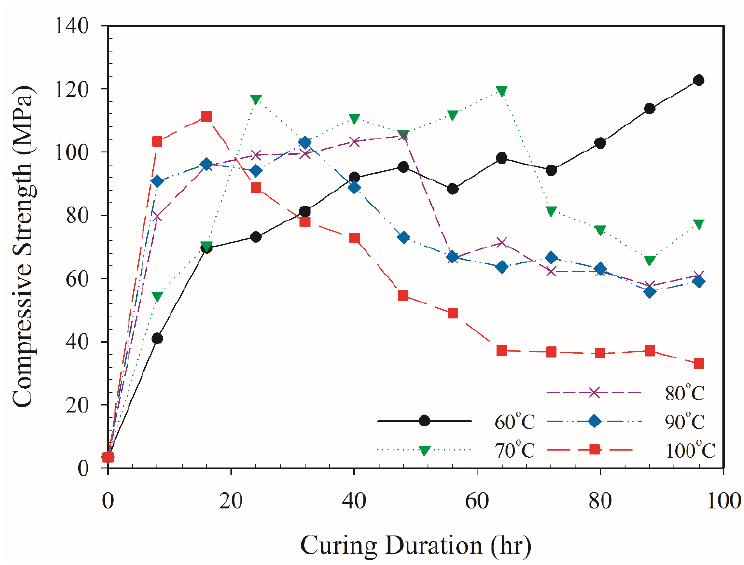
Figure 5. Variations with curing duration in the 4-day compressive strength of geopolymer specimens at various curing temperatures when AE% = 4%.